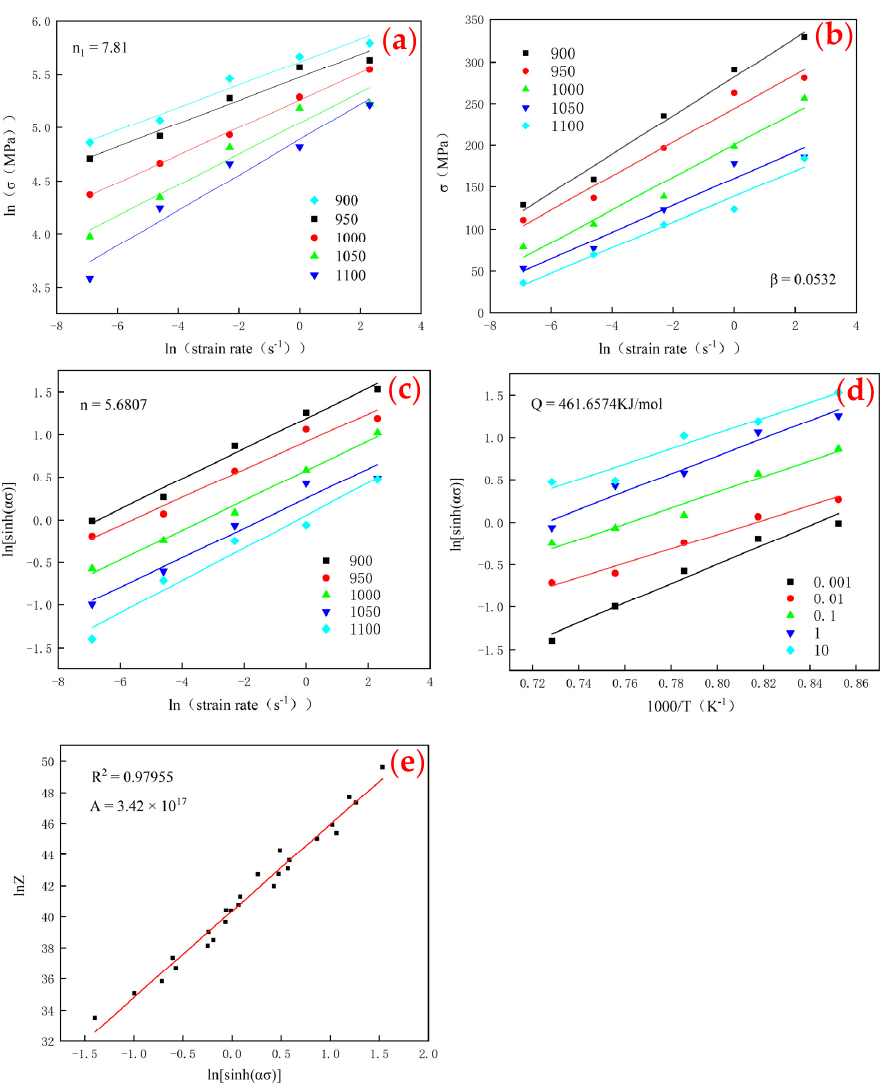
Figure 4. Fitting map of each parameter for the constitutive equation. ( a ) ln σ - ln ε (cid:4662) and fitting of n 1 , ( b ) σ -ln 𝜀 (cid:4662) and fitting of β , ( c ) ln (cid:4670)sinh(cid:4666) ασ )(cid:4671) -ln ε (cid:4662) and fitting of n, ( d ) ln (cid:4670)sinh(cid:4666) ασ )(cid:4671) -1 T ⁄ and fitting of Q, ( e ) ln(cid:4670)sinh(cid:4666)ασ)(cid:4671) − ln Z, fitting of A and the correlation coefficient (R 2 ) of the parameters.